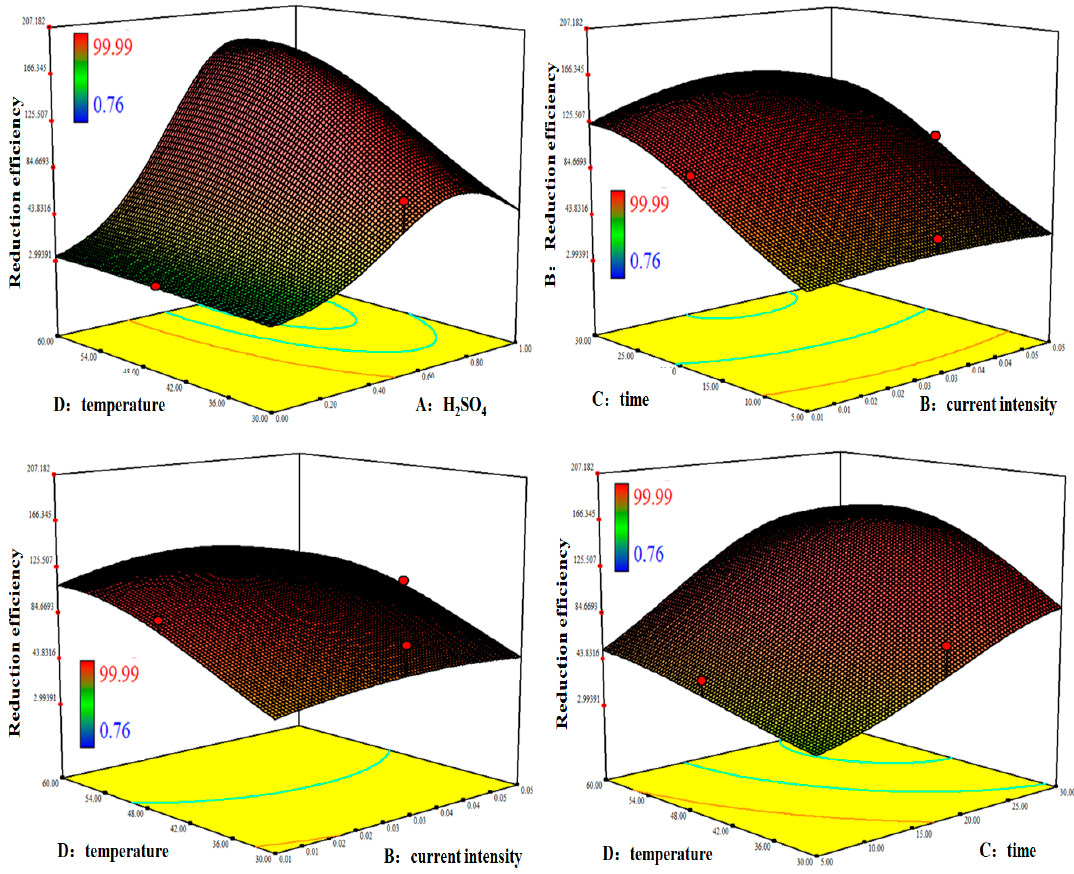
Figure 9. 3D Response surfaces of reduction efficiency.